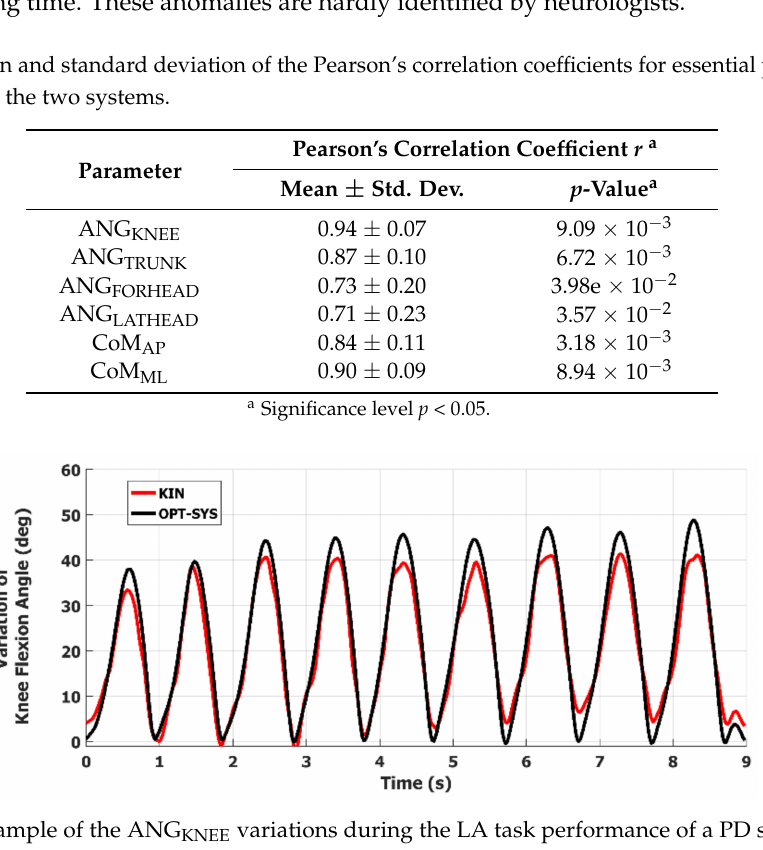
Figure 6. Example of the ANG KNEE variations during the LA task performance of a PD subject: the last movement at 8.9 s is characterized by significant reduction in both amplitude and